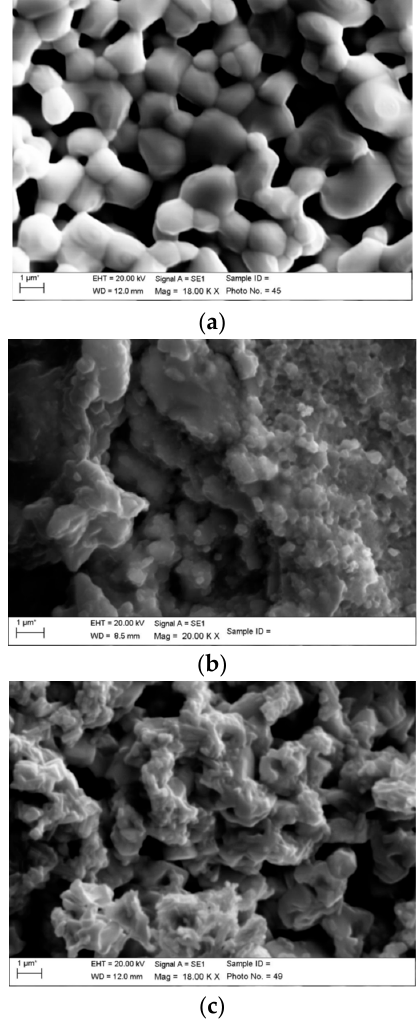
Figure 6. SEM cross-section images of the reference and the infiltrated samples after EIS